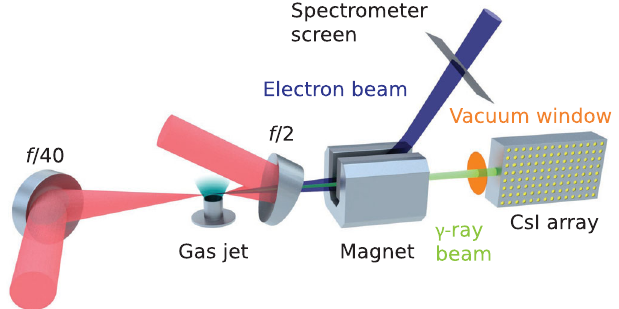
FIG. 1. Schematic of the experimental setup. All components are inside a vacuum chamber except for the CsI